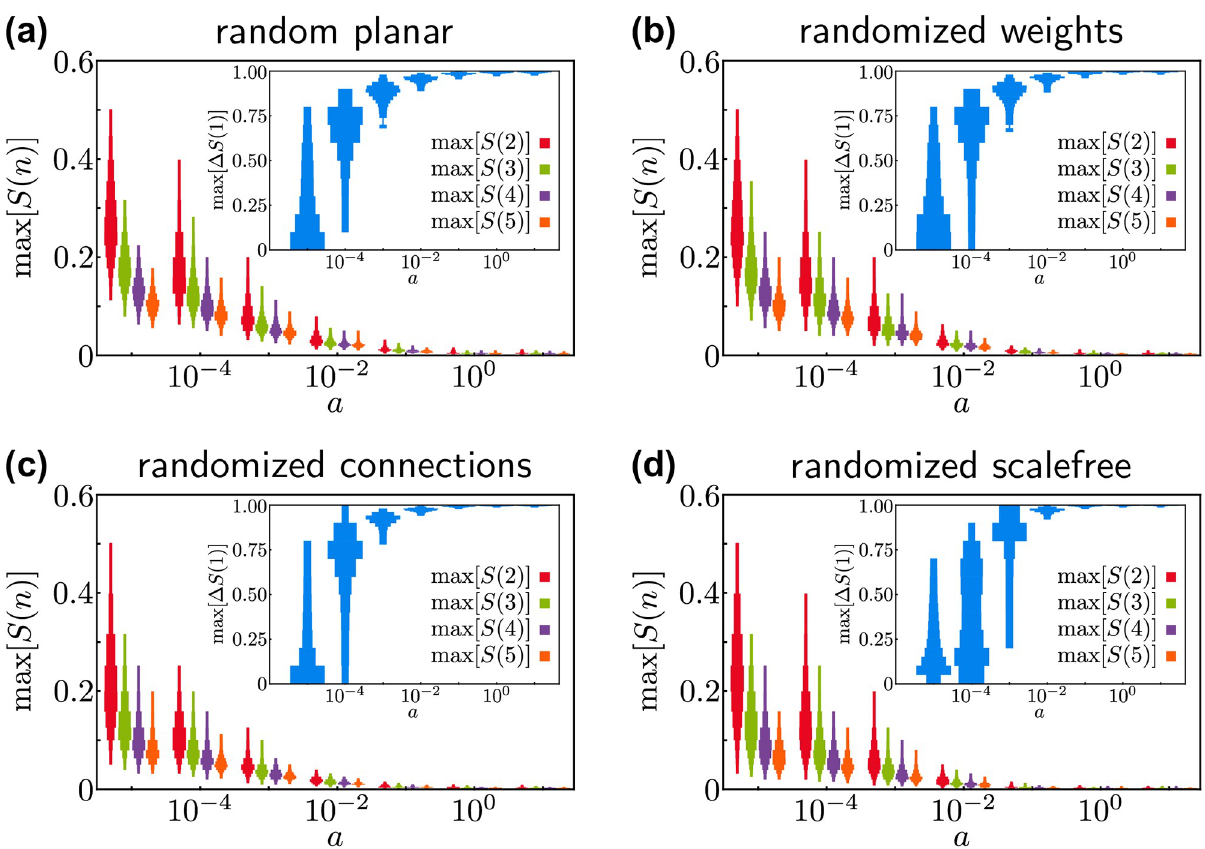
Fig 3. Multiple clusters or sudden growth? Distribution of the maximum size max[ S ( n )] of the n -th largest cluster and largest change max[ Δ S (1)] in the size of the largest cluster (insets) during the emergence of global connectivity for (a) the random planar network, (b) the network with randomized weights, (c) the network with uniformly randomized links and (d) the network with scale-free randomized links. For small a , multiple large clusters appear and merge slowly in all networks. For large a , a globally connected cluster suddenly forms from the individual nodes in a single large cascade before any other cluster had the chance to grow significantly. Depending on the value of the parameter a , nodes have to be competitive at different length scales to become the final supplier. The maximal size of the second largest cluster max[ S (2)](red) can serve as a proxy for this length scale.